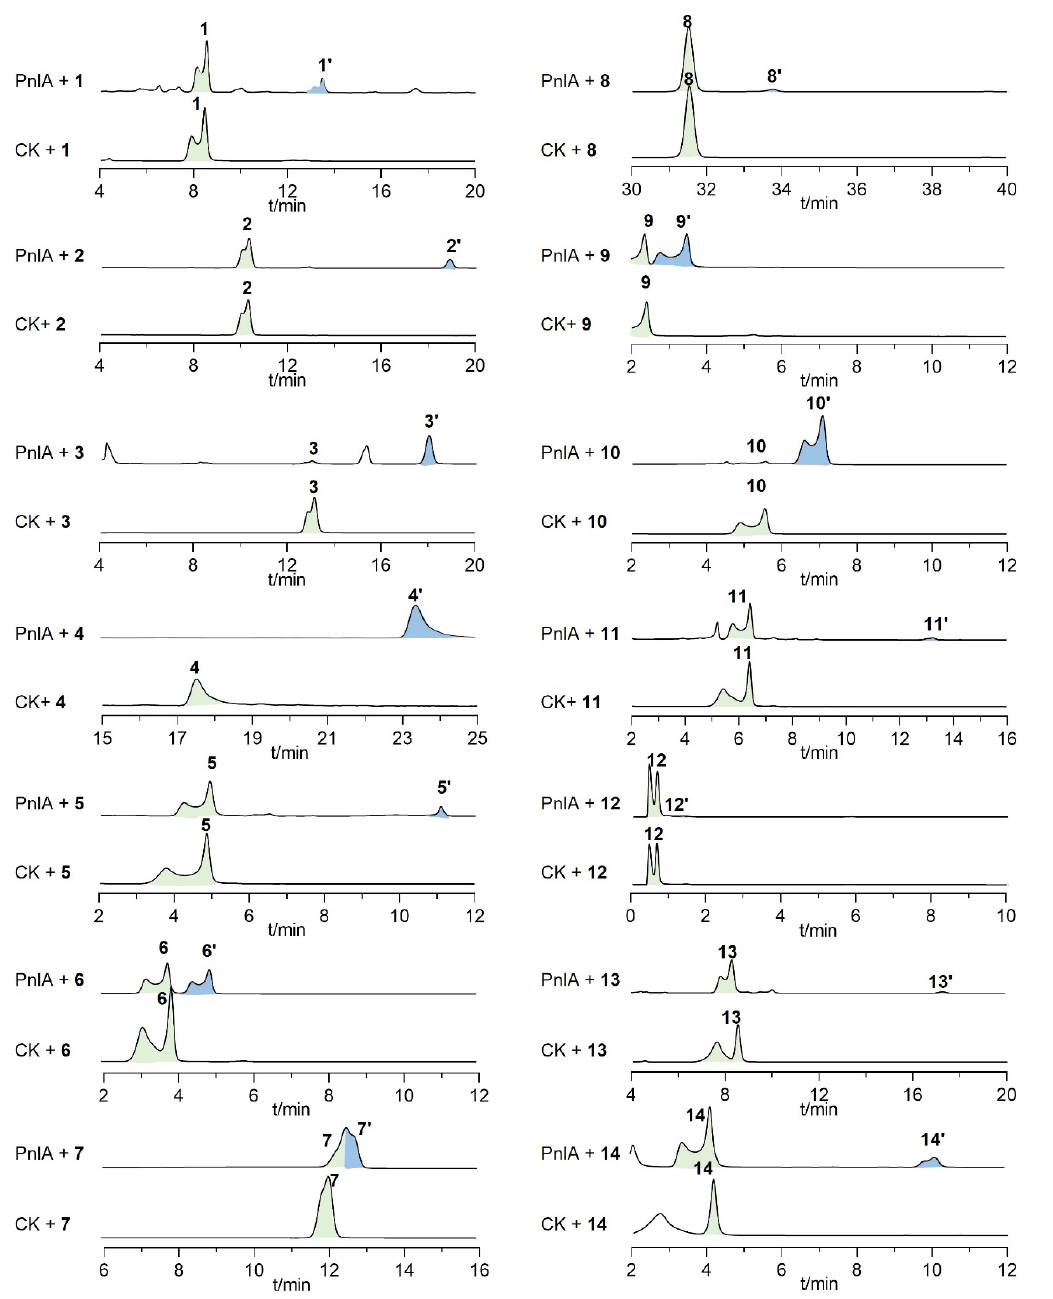
Figure 3. LC-MS analyses of the incubation mixtures of PnlA with different aryl carboxylic acid